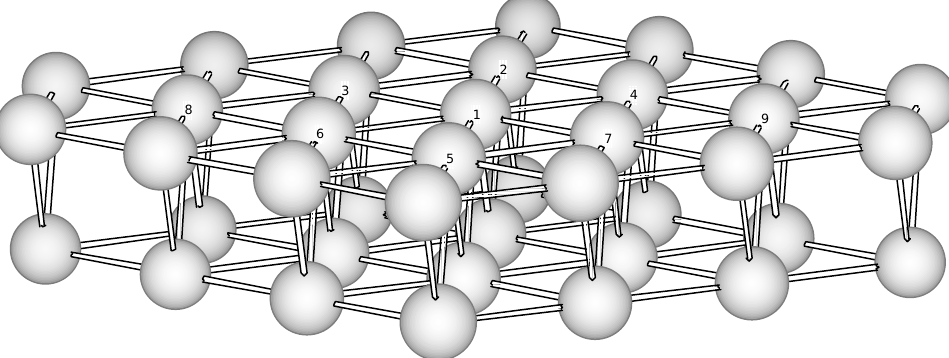
Figure 1. The 39-atom cluster used to model the Fe(110) surface (perspective view).